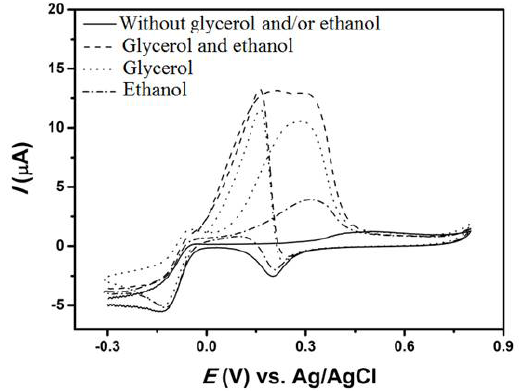
Figure 8. Selectivity test on GCE-ErGO-EAuNp sensor in the presence of ethanol